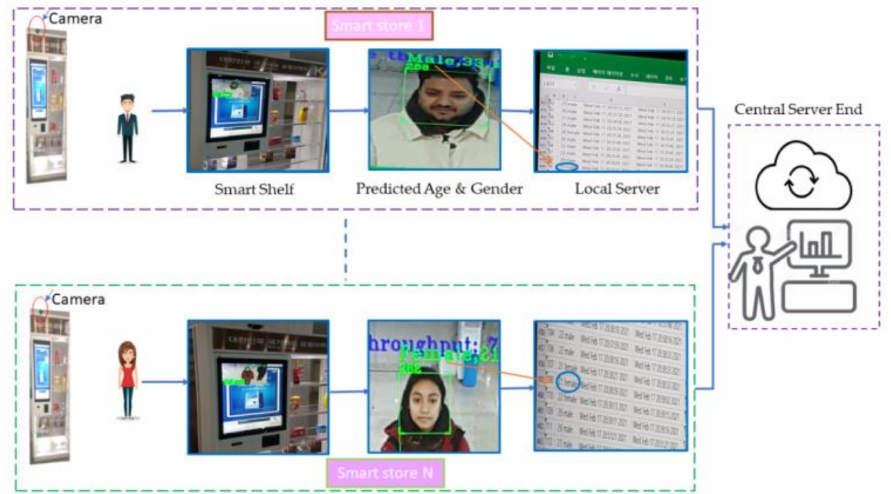
Figure 2. The process diagram of a smart store customer relationship management